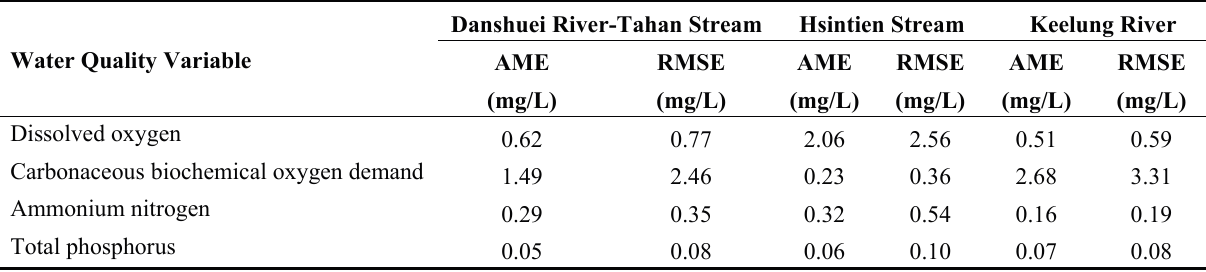
Table 5. Statistical error between simulated and measured water quality variables on 3 September 2010. Water Quality